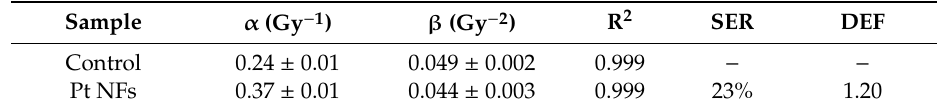
Table 1. Coe ffi cients α and β , R 2 , Sensitizing Enhancement Ratio (SER) and Dose Enhancing Factor (DEF) for HeLa cells irradiated by γ -rays without / with the presence of Pt NFs. Sample α (Gy − 1 ) β (Gy − 2 ) R 2 SER DEF Control 0.24 ± 0.01 0.049 ± 0.002 Pt NFs 0.37 ±